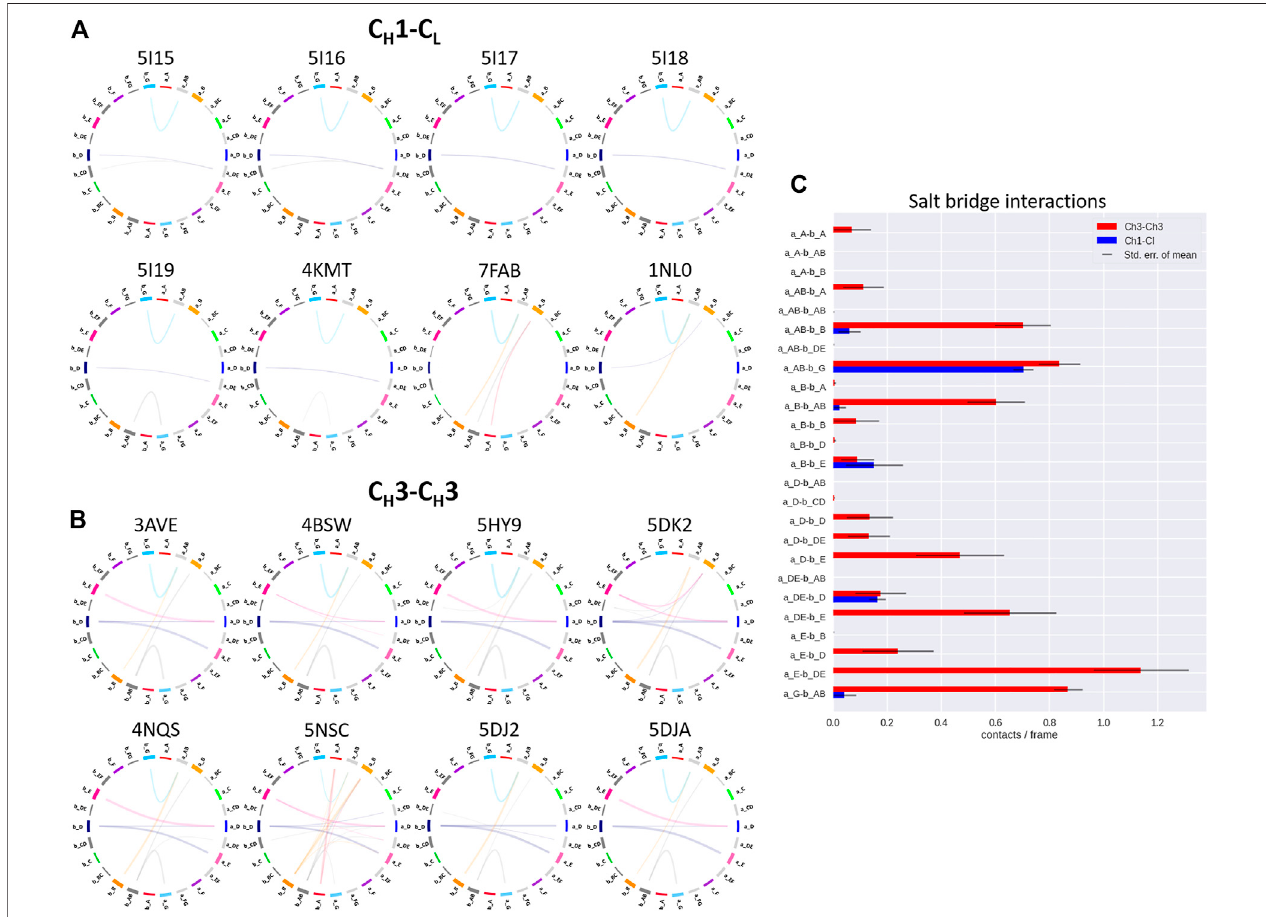
FIGURE 4 | Exemplary coarse-grained fl areplots showing the salt bridge interactions formed between the different interdomain β -strands and loops of both (A) C H 1-C L and (B) C H 3-C H 3 domains. (C) Bar plots quantitatively depicting differences in per strand/loop salt bridge interactions. We compare the two interface classes, i.e., C H 1-C L (blue) and C H 3-C H 3 (red). Thus, we show averages and standard errors of the mean of all investigated antibodies within the respective